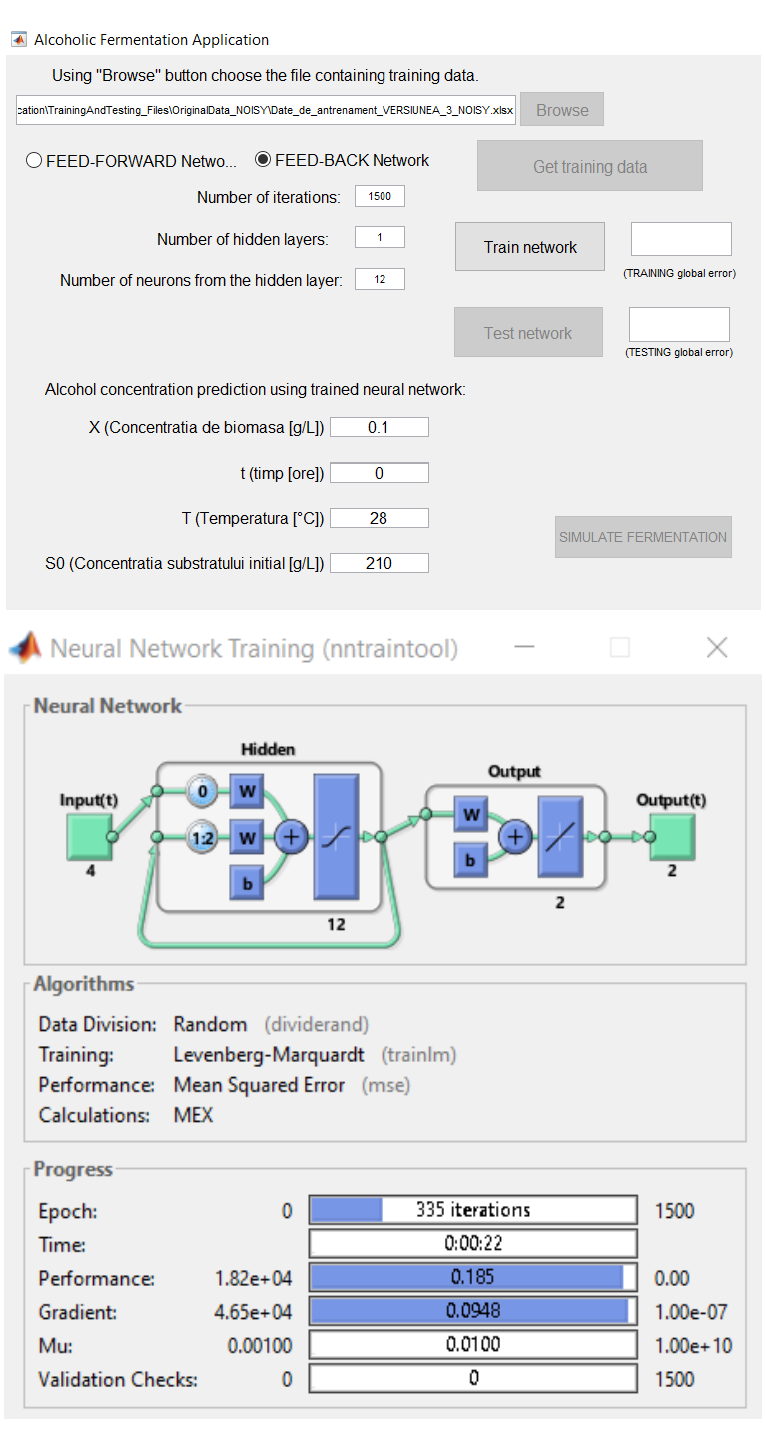
Figure 5. The graphical user interface of the software application.